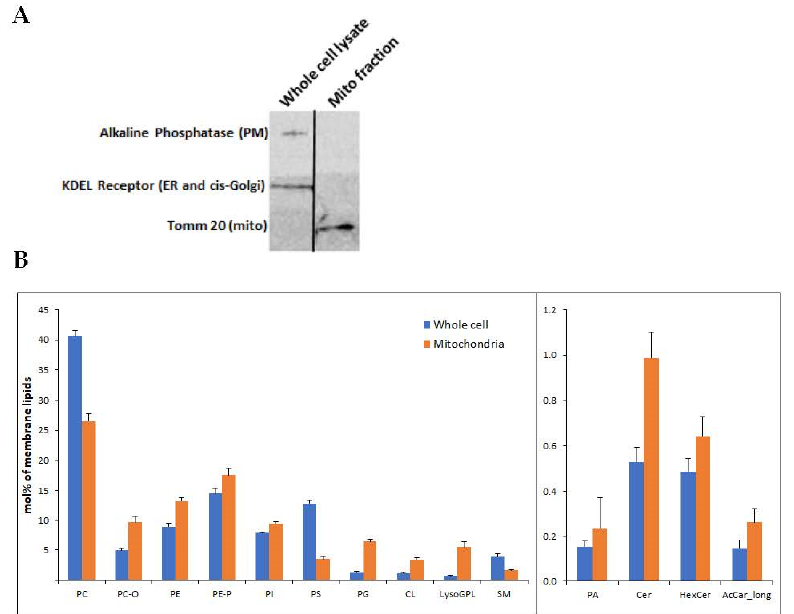
Figure 1. ( A ) Mitochondria were isolated from U118MG cells according to Kappler et al. The mito- chondrial isolate and an identical amount (20 μg) of the whole cell lysate were subjected to SDS- PAGE and immunoblotting using antibodies against the PM marker alkaline phosphatase, the en- doplasmic reticulum marker KDEL sequence and the mitochondrial marker Tom20. Representative results from 3 different experiments are shown. ( B ) Lipidomics of whole cell input and isolated mitochondrial fraction. The enrichment of CL ( p < 3.54 × 10 −9 ) and PG ( p < 2.68 × 10 −6 ) can be observed in the mitochondrial fraction, which is also depleted of several PM markers, such as PC ( p < 2.17 × 10 −8 ) and PS ( p < 2.91 × 10 −12 ). The levels of the other lipids were also different between whole cells and isolated mitochondria: PC-O ( p < 1.47 × 10 −7 ), PE ( p < 5.45 × 10 −7 ), PE-P ( p < 0.003), PI ( p < 4.00 × 10 −5 ), LysoGPL ( p < 0.0004), SM ( p < 0.001), PA ( p < 0.01), Cer ( p < 1.51 × 10 −6 ), HexCer ( p < 0.0004), AcCar_long ( p < 0.101). Shown are mean ± SEM, n = 6. Differences determined by Student’s t -tests. PC and PC-O, phosphatidylcholine (diacyl and alkyl-acyl); PE and PE-P, phosphatidylethanolamine (diacyl and alkenyl-acyl); PI, phosphatidylinositol; PS, phosphatidylserine; PG, phosphatidylglyc- erol; CL, cardiolipin; LysoGPL, Lyso glycerophospholipids; SM, sphingomyelin; PA, phosphatidic acid; Cer, ceramide; HexCer, hexosyl ceramide; AcCar_long, long-chain acylcarnitine. To identify the effect of 2OHOA treatment on the mitochondrial lipidome of U118MG cells, we performed quantitative mass spectrometry-based shotgun lipidomics. At the membrane lipid level, the mitochondrial fraction, compared to the whole-cell in- puts, manifests enrichment in the mitochondrial membrane markers cardiolipin and phosphatidylglycerol and depletion in the plasma membrane markers phosphatidylserine and sphingomyelin (Figure 1B). 2OHOA treatment resulted in a very clear separation of non-treated vs. treated mi- tochondrial lipidomes as assessed by principal component analysis (Figure 2A). The main effect of 2OHOA on mitochondrial membranes was its incorporation into glycerophos- pholipids (Figure 2B and Table A1). C2-hydroxylated and odd-chain species indicate the esterification of 2OHOA in its original form [16] and after conversion to 17:1 fatty acid, respectively. This was especially pronounced in mitochondrial phosphatidylcholine and cardiolipin, which incorporated 2OHOA and 17:1 fatty acyl moieties at similar propor- tions. As a result, the ratio of hydroxylated lipid species accounted for 50–60% of the cor- responding non-2OHOA-generated species following 2OHOA treatment (Figure 2C). An- other significant effect of 2OHOA on mitochondrial membranes is a decrease in the level